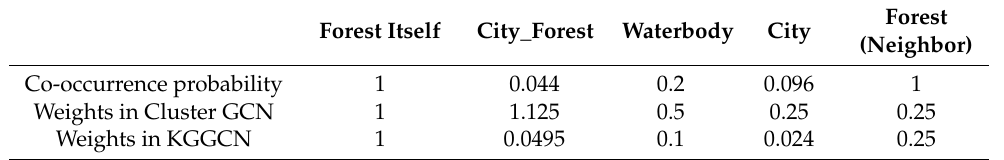
Table 7. Comparison of weights in Cluster-GCN and KGGCN. Forest